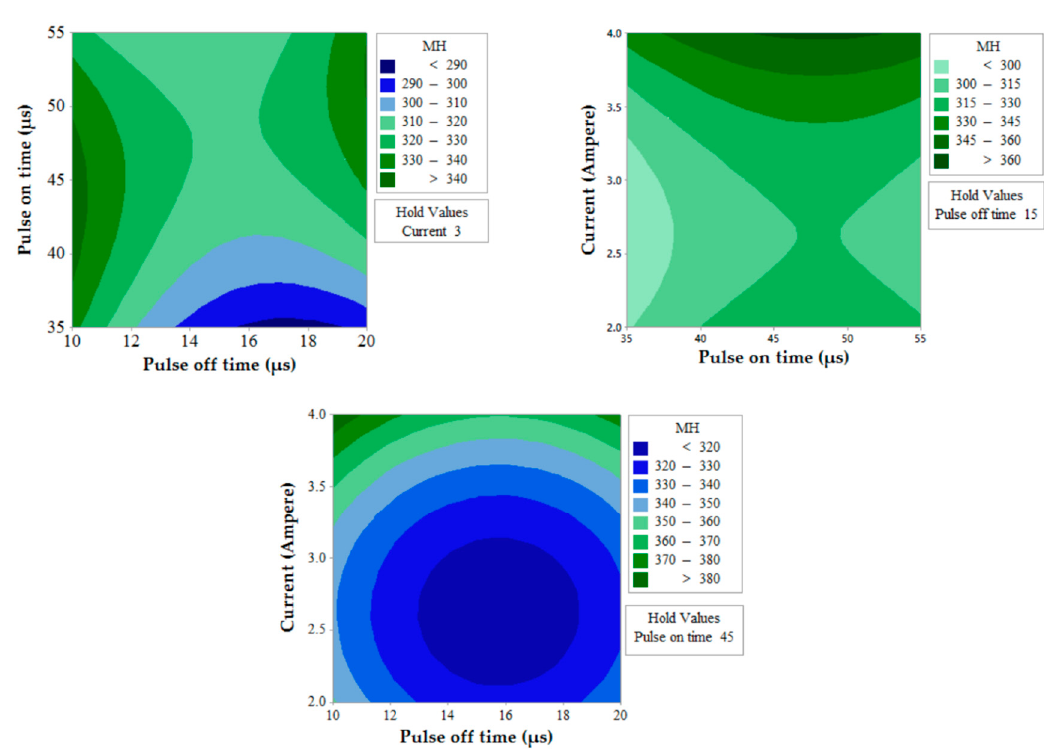
Figure 8. Contour plot for MH.